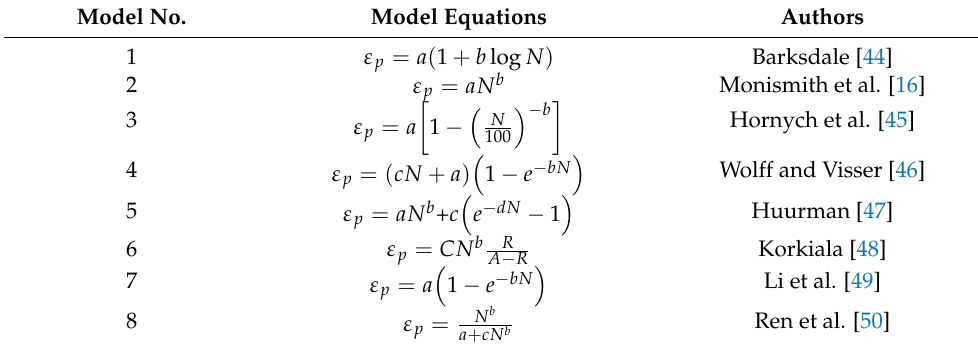
Table 3. Commonly used regression models for permanent deformation prediction. Model